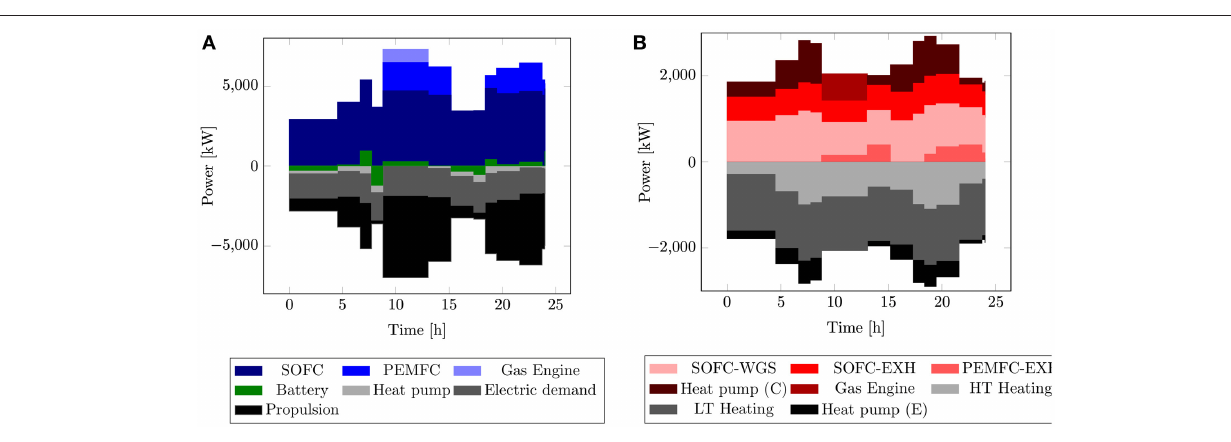
FIGURE 9 | Share of power generation and demand for typical day one, cruise ship case. (A) Power, (B)